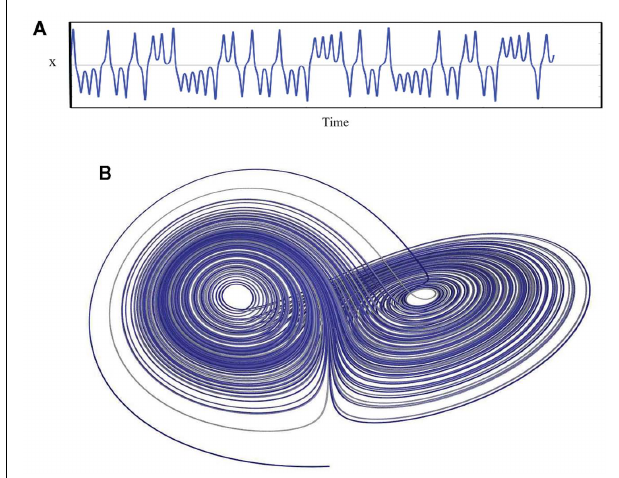
FIGURE 7 |A plot of the Lorenz attractor. (A) represents a the time series for single variable ( x ) while (B) illustrates the changing relationship between all three variables.The weather model that produced this plot consists of three differential equations: (1) d x /d t = σ ( y − x ), (2)